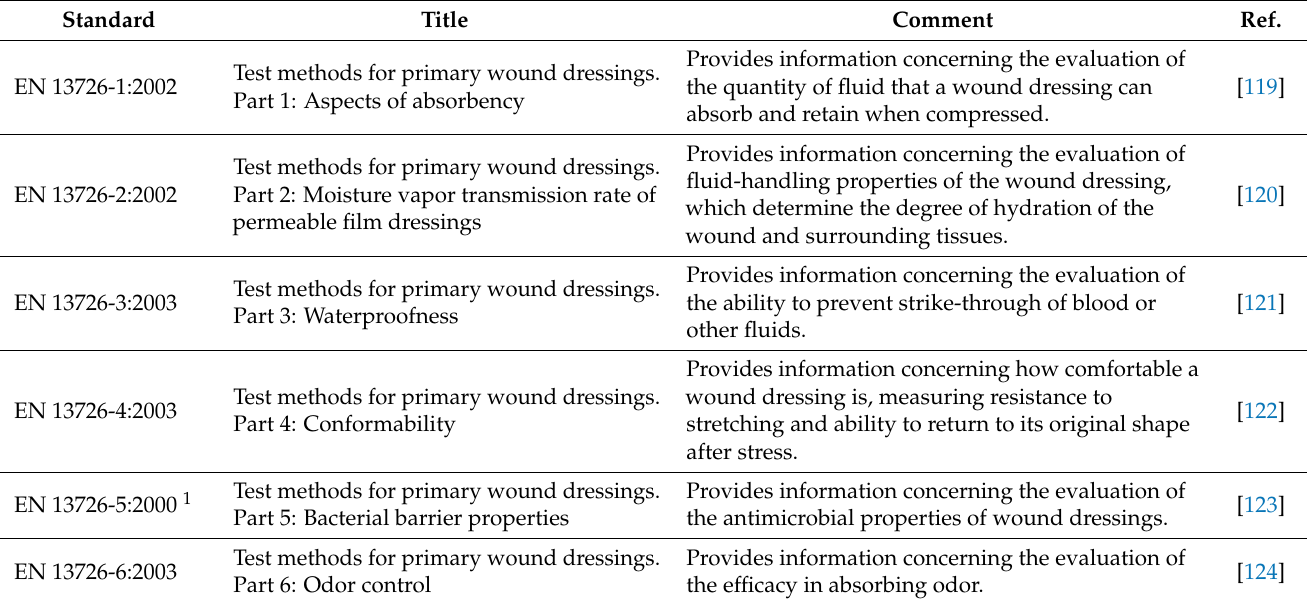
Table 5. European Standards (EN) applicable to the physical characterization of primary wound dressings.